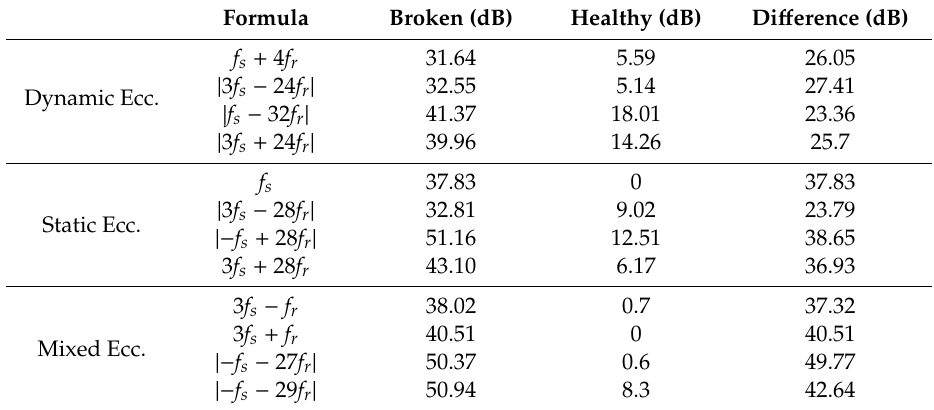
Table 9. Results of harmonics amplitude measurements of the characteristic frequency for a rotor cage fault, obtained from FEM